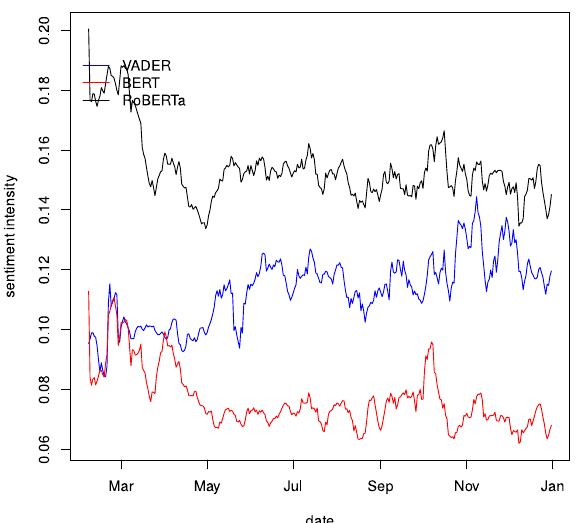
Figure A4. Year–Long time series of daily averaged negative sentiment polarity of COVID-19-related tweets in Mexico . Each line represents a time series based on the same dataset collected [6] and restricted to Mexico, from 2 February to 31 December 2020. Data were smoothed via a 7-day rolling mean.